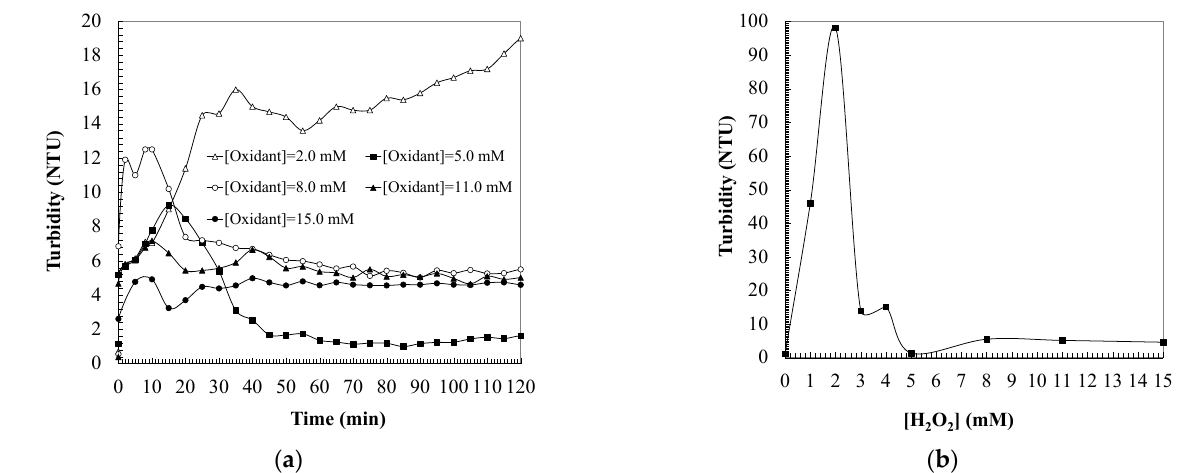
Figure 4. ( a ) Effect of hydrogen peroxide concentration ((Oxidant), mM) on turbidity changes in a photo-Fenton system during the carbamazepine oxidation. ( b ) Effect of hydrogen peroxide on the solutions turbidity once achieved the steady state. Experimental conditions: (CBZ) = 50.0 mg/L; pH = 3.0; (Fe) = 10.0 mg/L; (UV) = 150 W; T = 40 °C.